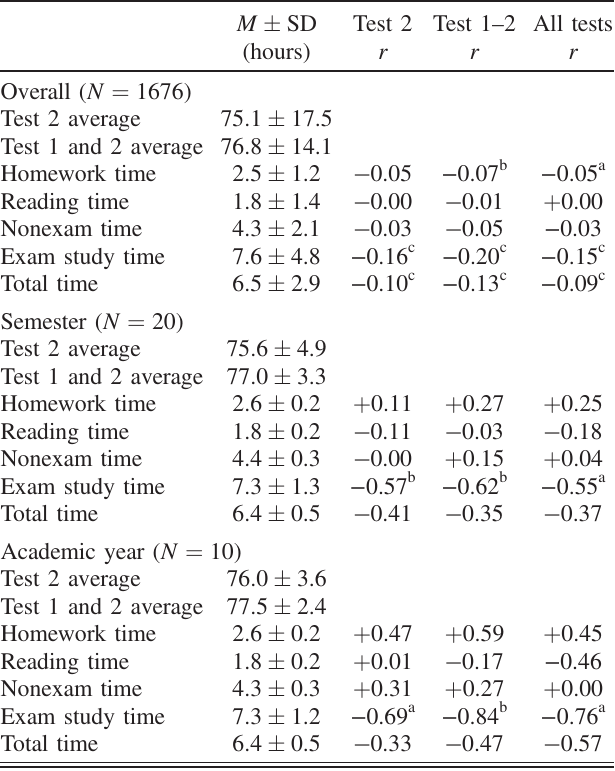
TABLE II. Summary of the correlation r of time on task with the score on the second in-semester examination, the average on the first two in-semester evaluations, and the overall in-semester evaluation average. The mean ( M ) and standard deviation (SD) are also